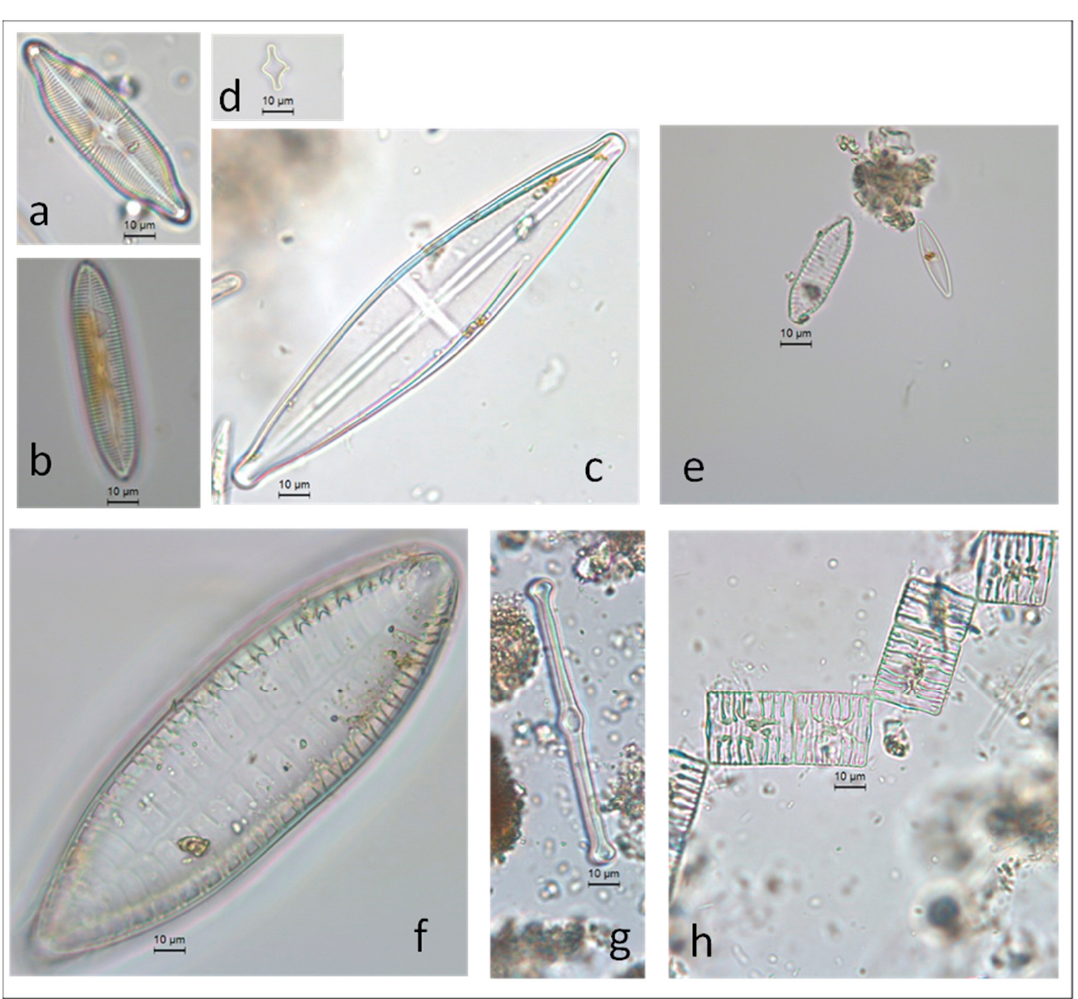
Figure 5. ( a ) Pinnularia microstauron var. nonfasciata, ( b ) P. viridis , ( c ) Stauroneis anceps , ( d ) Staurosira construens , ( e ) Surirella angusta , ( f ) S. robusta , ( g ) Tabellaria fenestrata , and ( h ) T. flocculosa . Scale bar: 10 μ m.